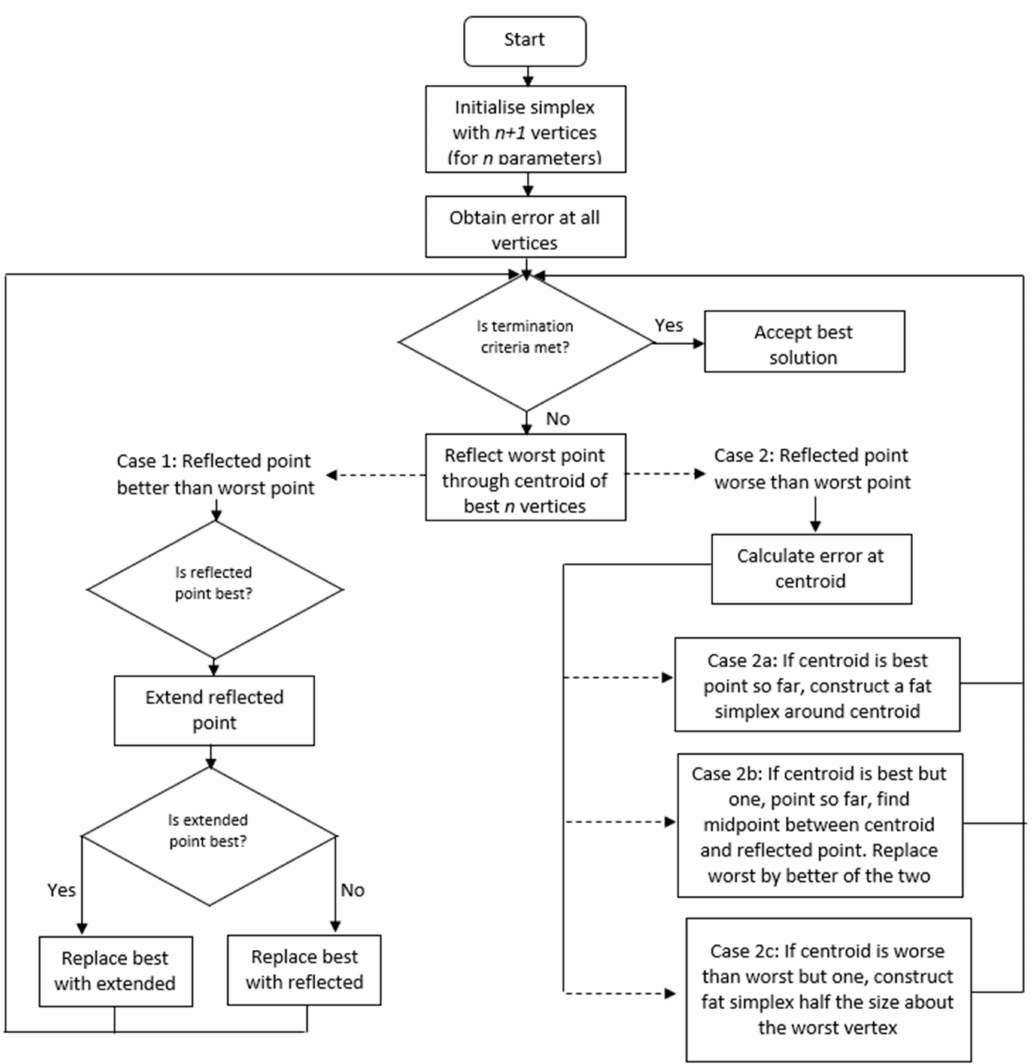
Figure 10. Flowchart for the Nelder-Mead optimization